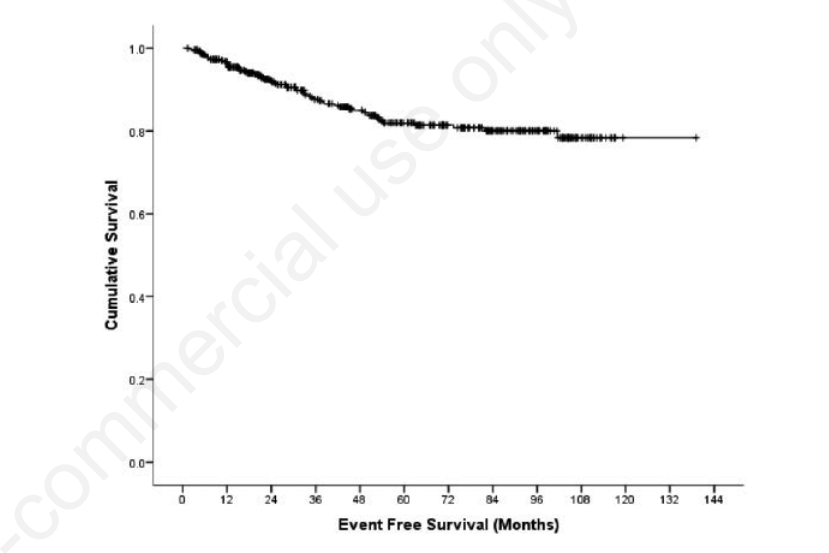
Figure 2. Event free survival of the whole